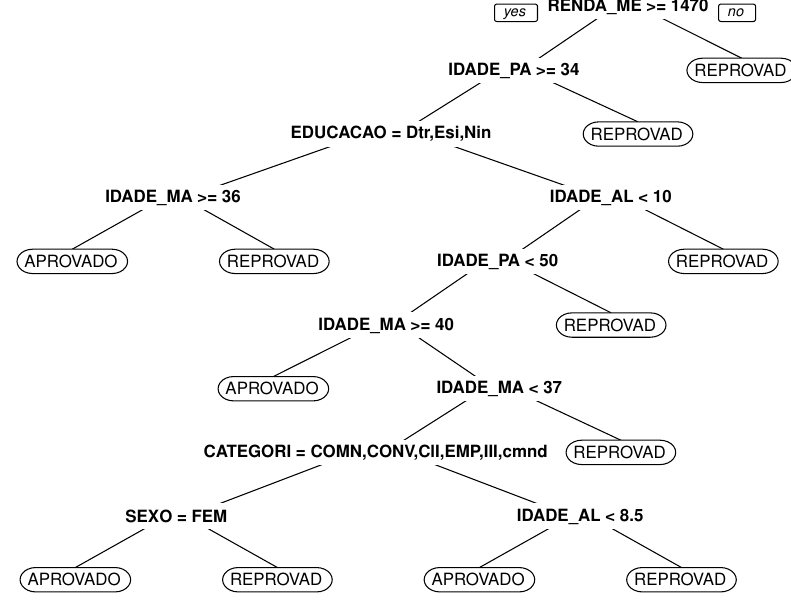
Figure 17. Tree grown using qualifiers and